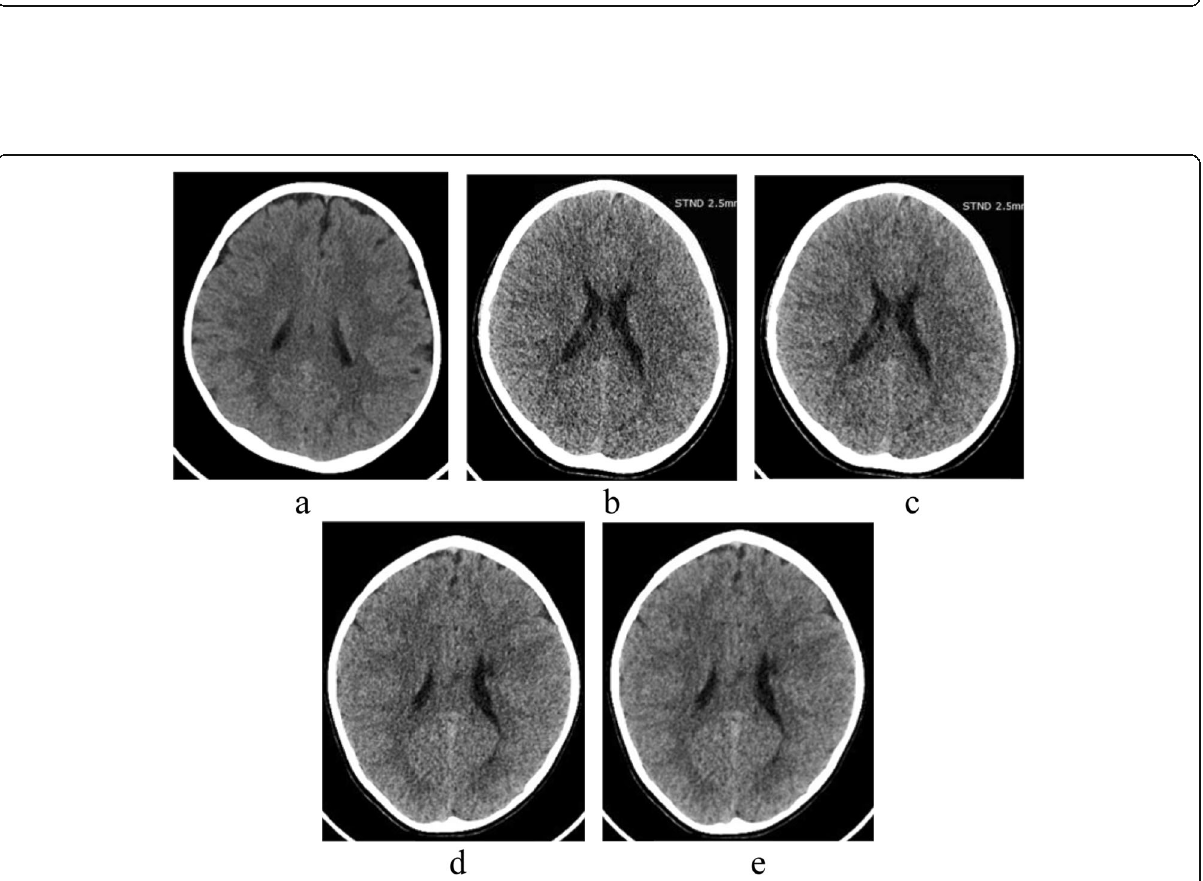
Fig. 5 Image quality of CT images at the level of corona radiata. Non-ASIR CT image ( a ), 60% ASIR-V ( b ), and 80% ASIR-V ( c ) CT images using 40- mA tube current reduced CT protocol, and 60% ASIR-V ( d ) and 80% ASIR-V ( e ) CT images using 60-mA tube current reduced CT